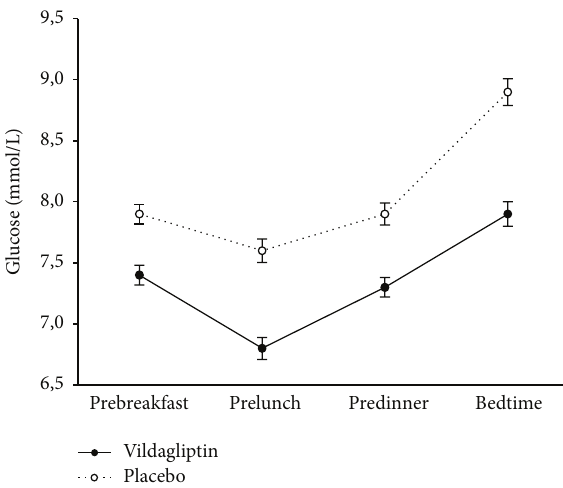
Figure 1: Mean average glucose data before breakfast, before lunch, before dinner, and at bedtime in patients with type 2 diabetes treated with vildagliptin (solid line) or placebo (dotted line) as add-on to insulin in a crossover design ( 𝑛 = 29 ). Data are mean ±